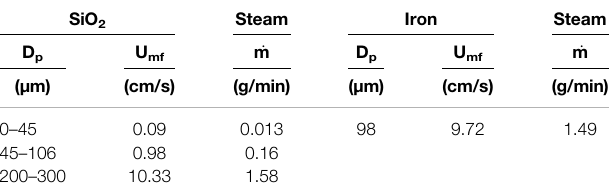
TABLE 3 | Minimum fl uidization velocity for the powder.